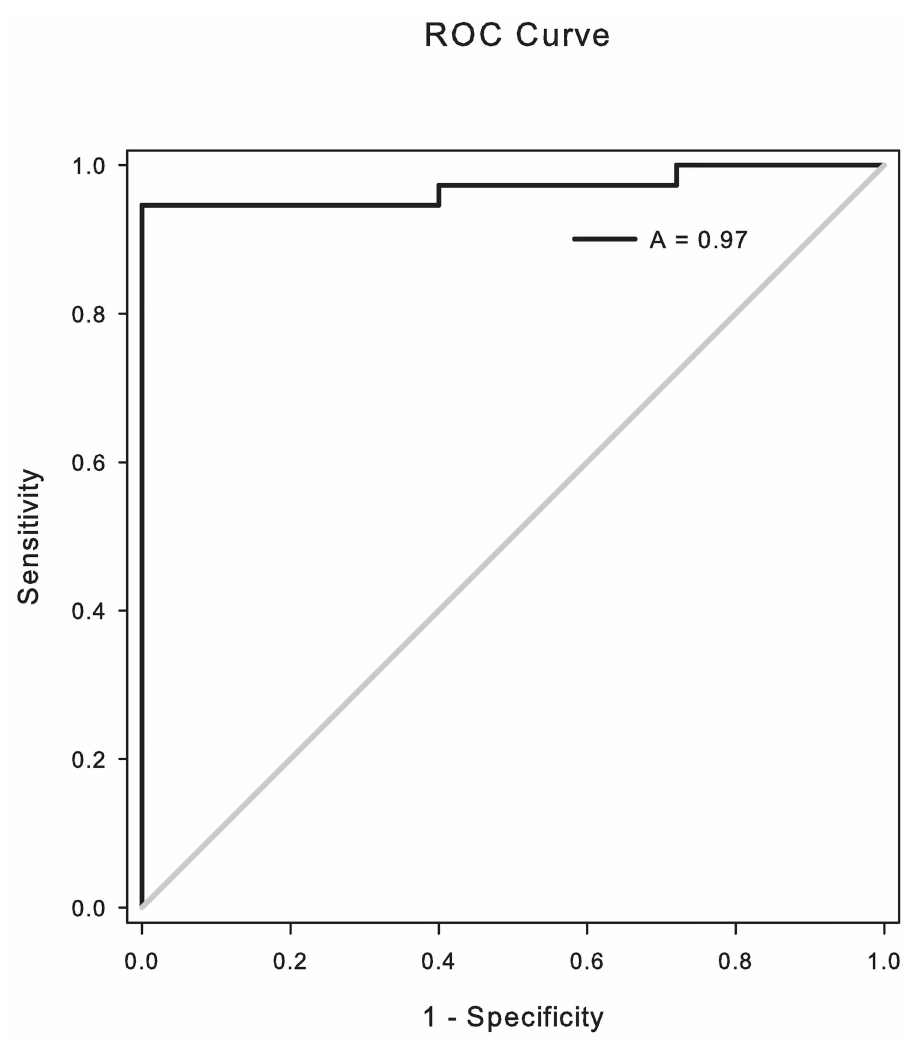
Fig 2. ROC curve analysis shows a high degree of diagnostic accuracyfor the assay. Sensitivity and 1-Specificity were plotted for healthydogs (n = 25) and dogs confirmedwith coccidioidomycosis (n = 37). Estimated area under the curve (A) is